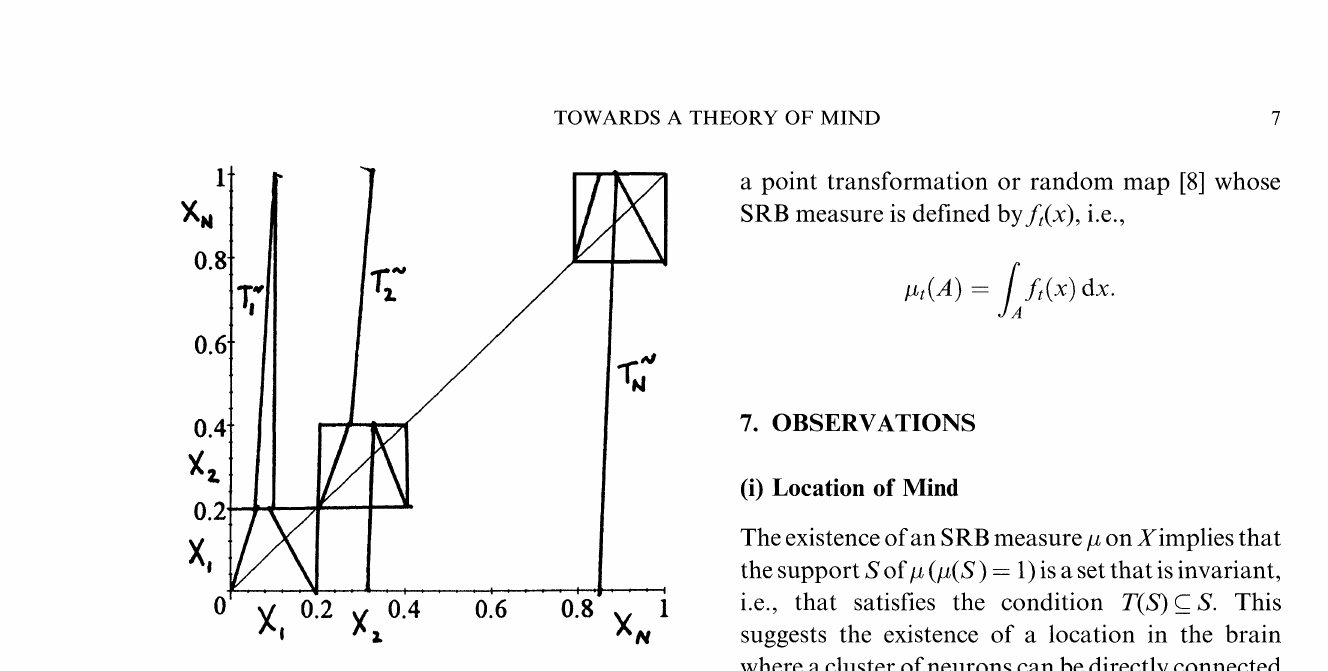
FIGURE 5 Interacting